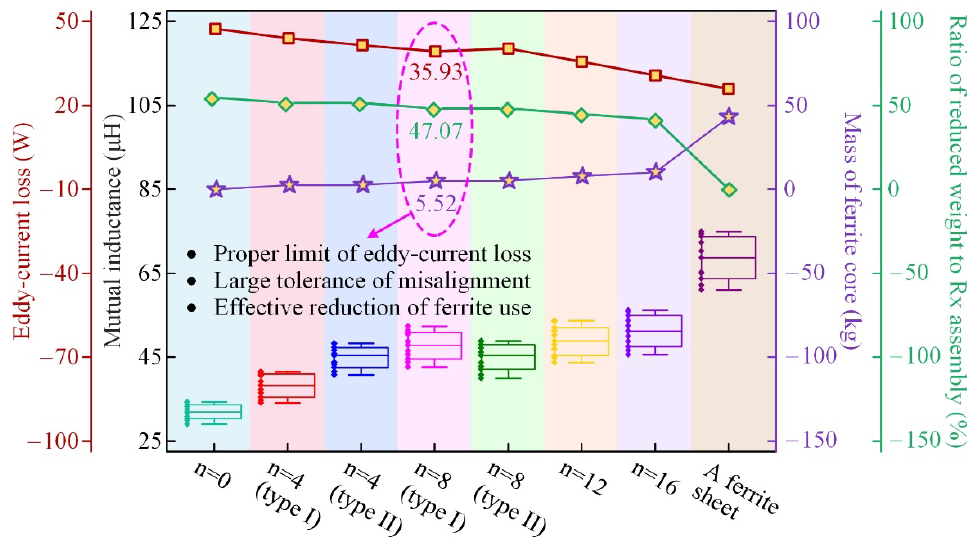
Figure 14. Performance of different lightweight designs in view of reduced weight of ferrite core, degree of magnetic coupling, and eddy current loss of shielding sheet.